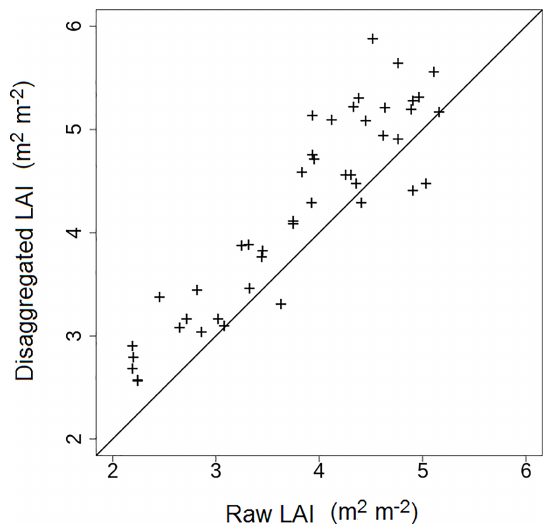
Figure 11. Comparison of mean annual LAI max of the raw GEOV1 product and of the disaggregated GEOV1 product.